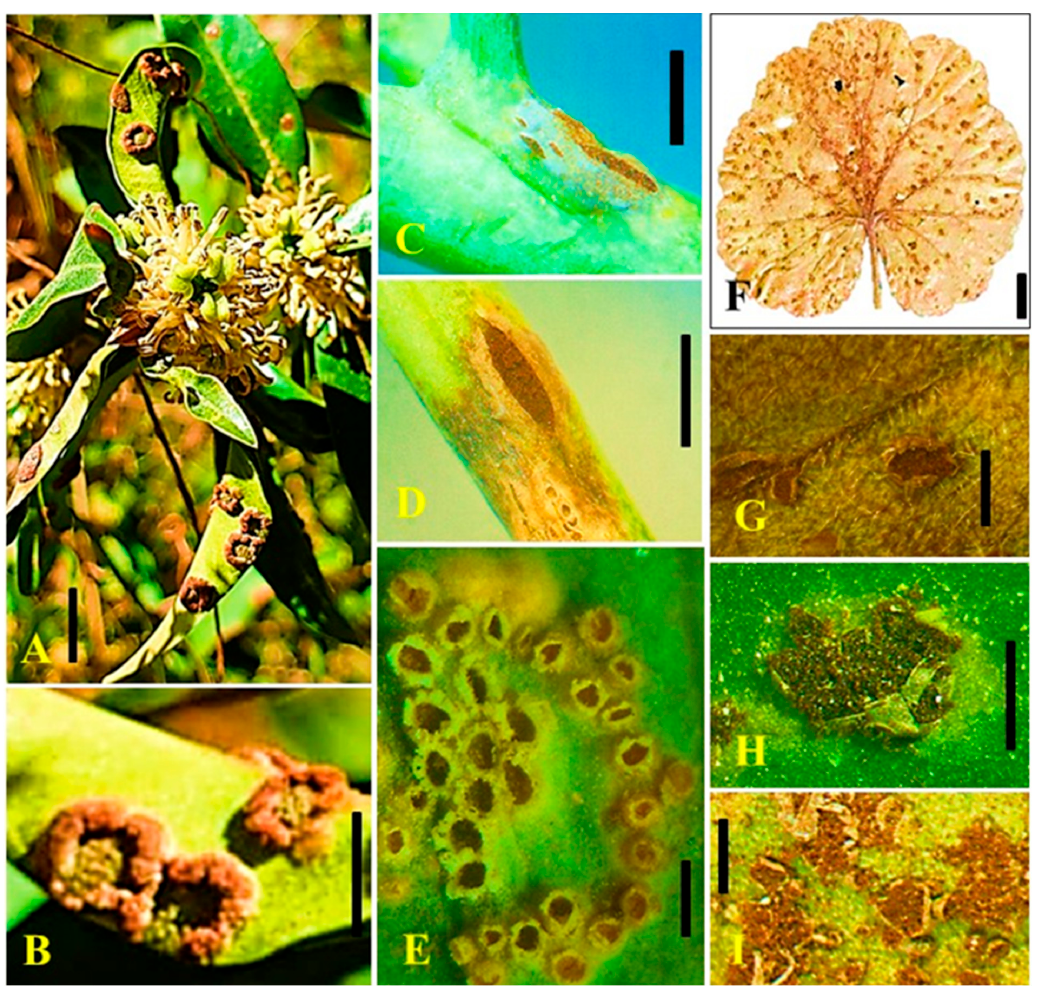
Figure 1. Disease symptoms of species of Uromyces . ( A , B ) Uromyces ambiens on Buxus wallichiana ; ( C – E ) Uromyces fabae on Pisum sativum ; ( F , G ) Uromyces geranii on Geranium sp.; ( H , I ) Uromyces trifolii on Trifolium sp. Scale bar: A – I = 1 mm.